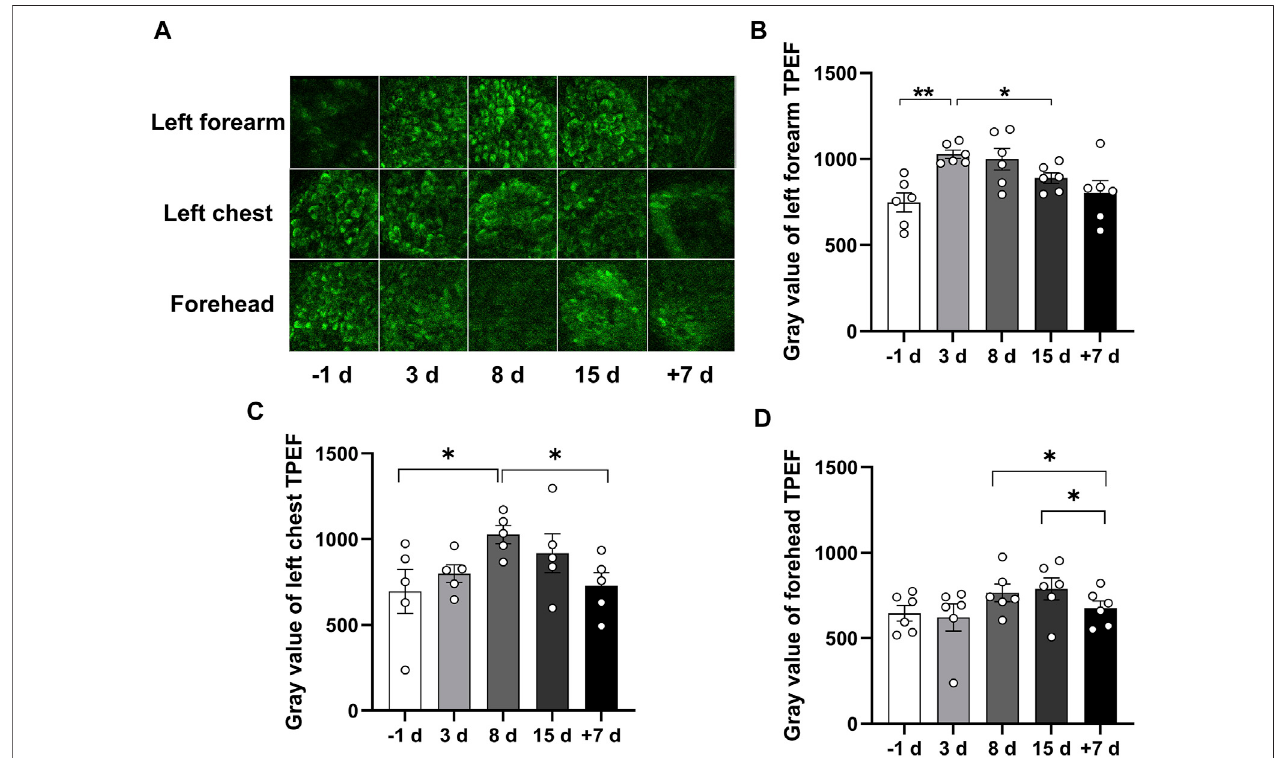
FIGURE 3| Qualitative comparison of skin TPEF during 15 days ofhead-down bed rest. (A) Typical images of TPEF intensity in the subcutaneousbasale cell layer indifferentpartsoftheskinateachtimepoint. (B – D) ChangesofTPEFintensityintheskinbasalecelllayerofleftforearm,leftchestandforeheadduring15 daysofhead- down bed rest. Data represent mean ± SEM. Signi fi cant values are determined as * p < 0.05, ** p < 0.01 (Tukey ’ s multiple comparisons paired test).